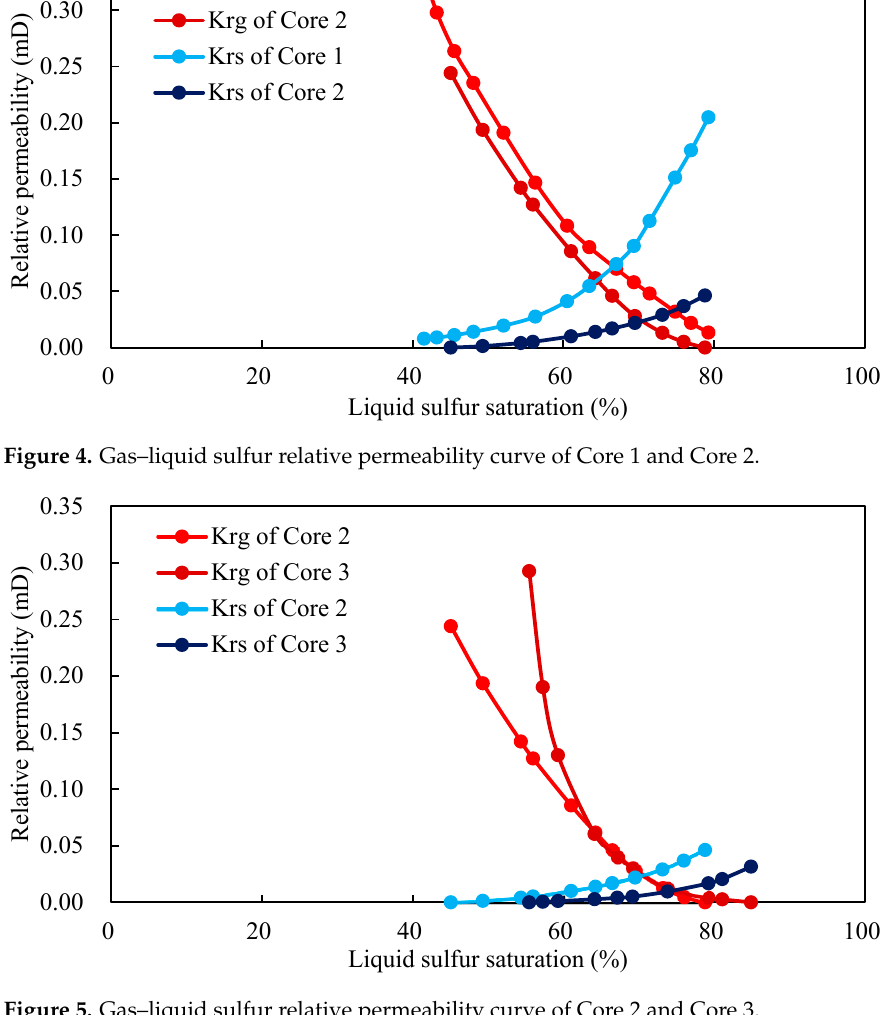
Figure 5. Gas–liquid sulfur relative permeability curve of Core 2 and Core 3. Table 5. Endpoints and isopermeability point parameters of the relative permeability of differ- ent